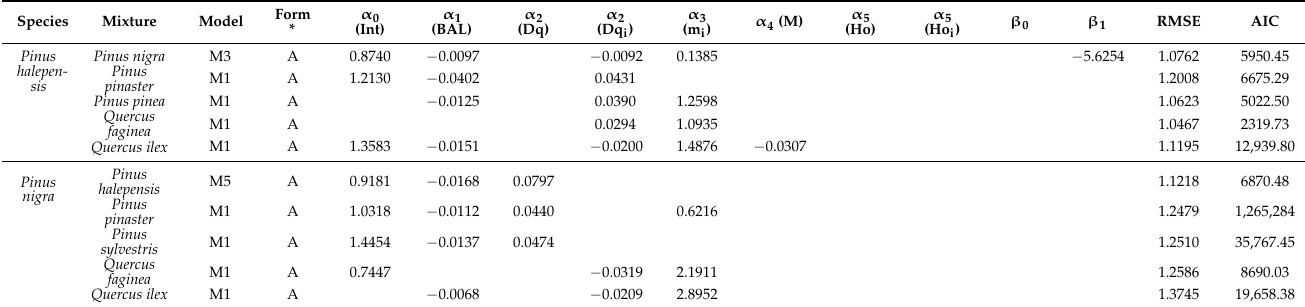
Table 2. Estimated model coefficients for the selected H–D models for the different species and species